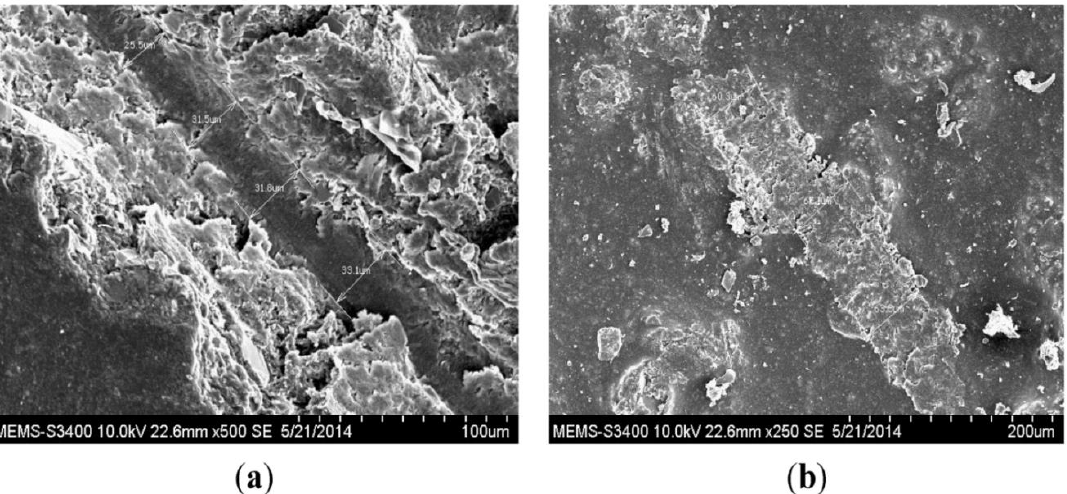
Figure 22. SEM pictures of ( a ) fractured virgin specimen ( b ) fractured healed specimen [203].